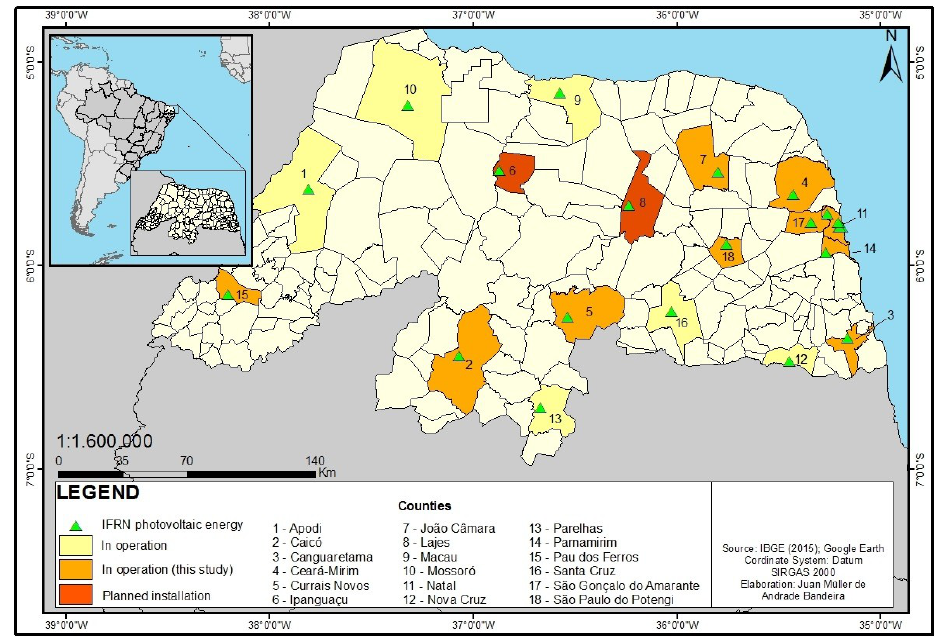
Figure 8. Map exhibiting the geographic distribution of the evaluated power plants. The Datum Sirgas 2000 coordinate system was used; data were sourced from Reference [67].